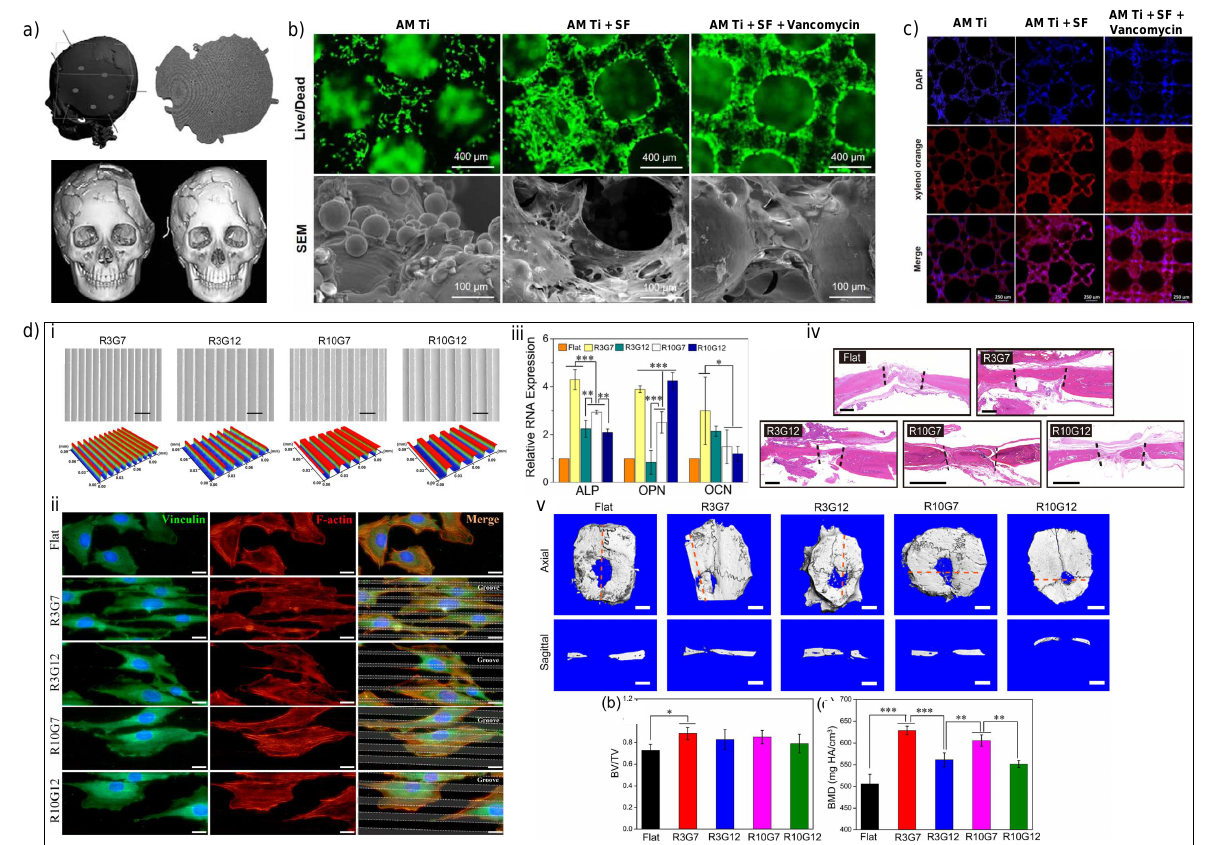
Figure 5. The biological properties of AM Ti-based implants. ( a ) Custom-made Ti-6Al-4V-ELI AM implants helped to reconstruct the skull defect of 21 patients [74]. ( b ) Silk fibroin and vancomycin coating promoted the survival of MC3T3-E1 cell line seeded on 3D printed Ti implants [82].( c ) Silk fibroin and vancomycin coating promoted the calcium deposition of MC3T3-E1 cell line seeded on 3D printed Ti implants [82]. ( d ) The micropattern of Ti substrates induced osteogenesis. ( i ) SEM images and 3D surface profile of different micropatterns. ( ii ) MC3T3-E1 preosteoblasts aligned along the ridges in R3G7 micropattern. ( iii ) The R3G7 microgroove pattern promoted osteogenesis of MC3T3-E1 cells. ( iv ) and ( v ) The R3G7 microgroove pattern induced bone regeneration in rat skull defects [80]. *: p < 0.05; **: p < 0.01; ***: p <